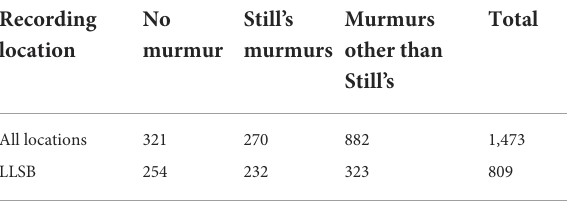
TABLE 2 Distribution of pathological and innocent murmurs other than Still’s at all locations ( N =